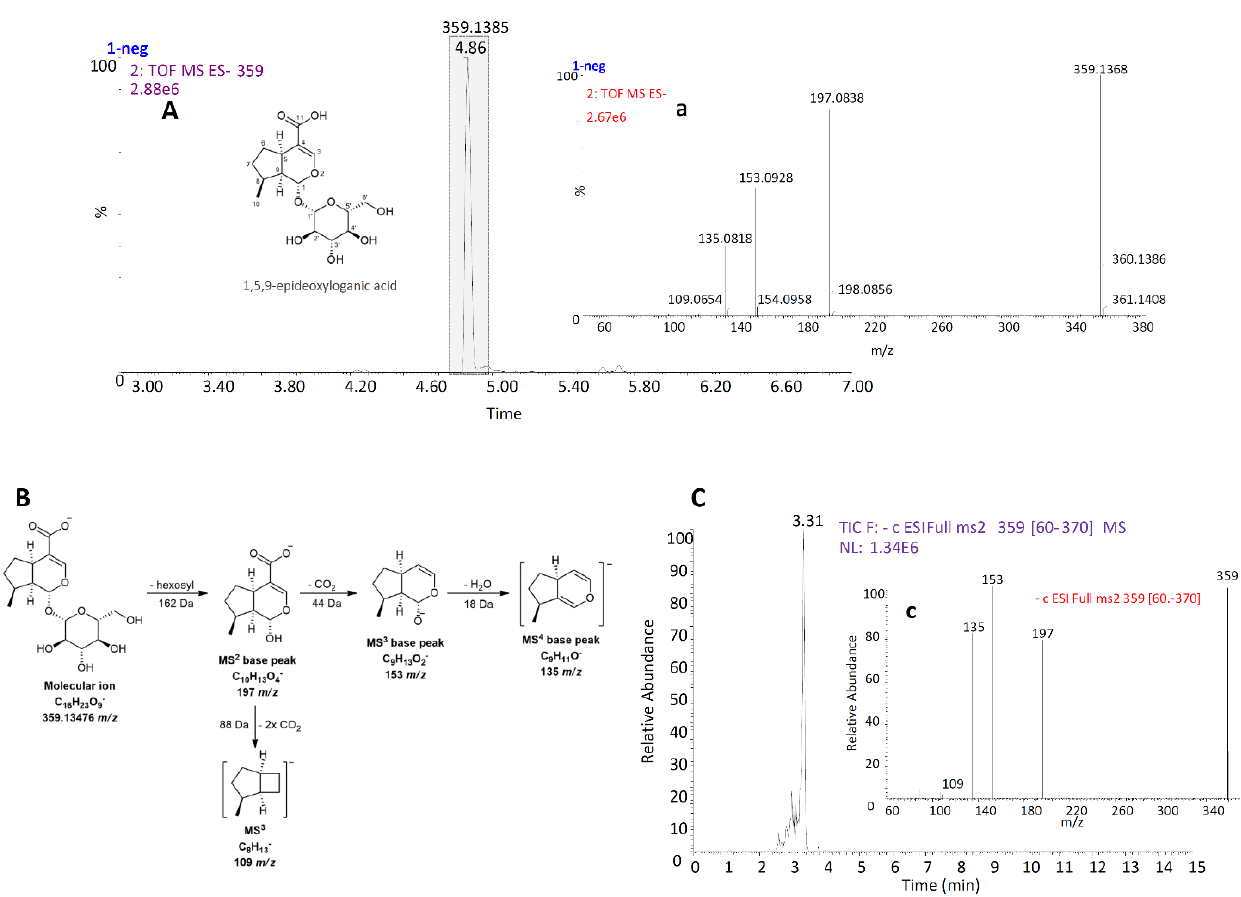
Figure 2. UPLC/Q-TOF MS chromatogram of N. rtanjensis methanol extract ( A ), with extracted mass for pseudomolecular ion [M − H] − at m/z 359, corresponding MS 2 spectrum of 1,5,9-epideoxyloganic acid (a), and proposed fragmentation pathway ( B ). Following preparative isolation of 1,5,9-epideoxyloganic acid from methanol extract, its structural characterization included UHPLC/MS 2 analysis. UHPLC/qqqMS 2 chromatogram ( C ) and corresponding ( − )MS 2 spectrum (c) are presented.